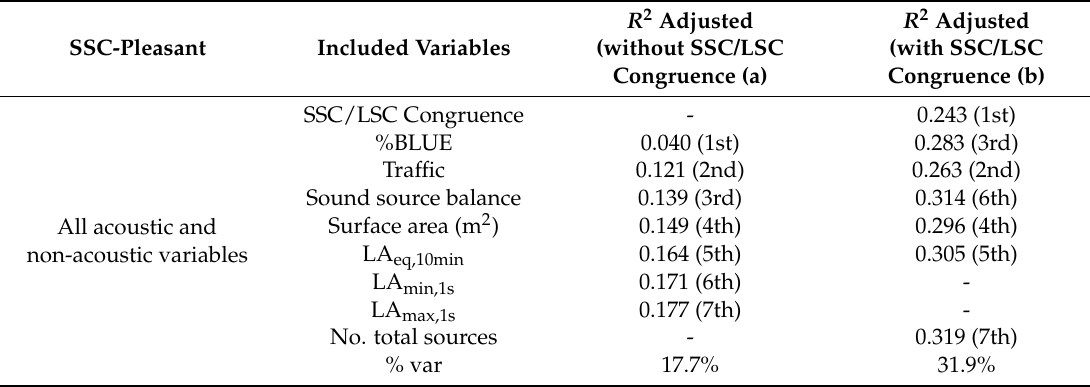
Table 7. Linear regression analysis (step-by-step method): percentage of variance (%var) of soundscape pleasantness (SSC-Pleasant) explained by acoustic and contextual variables (a) without SSC/LSC congruence (F(6.395) = 14.378; p < 0.001) or (b) including SSC/LSC congruence (F(7.386) = 27.266; p < 0.001). R 2 Adjusted SSC-Pleasant Included Variables (without